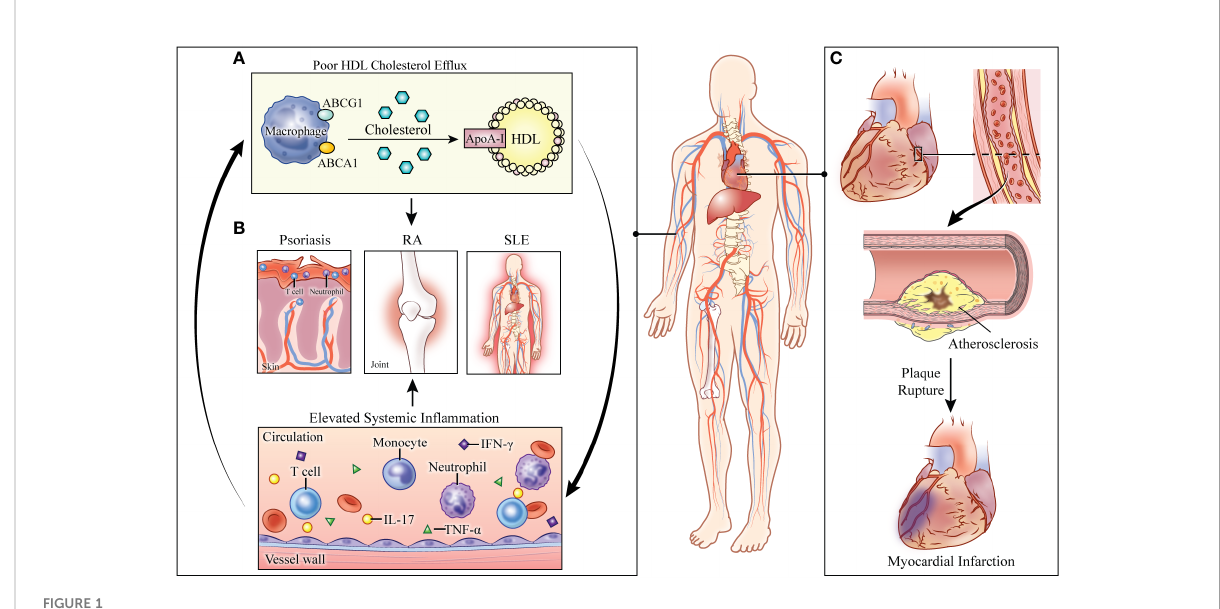
FIGURE 1 Consequences of abnormal cholesterol transport in systemically in fl amed pathologies. (A) Defective cholesterol ef fl ux capacity (CEC) perpetuates immune cell proliferation and activation. Elevated systemic in fl ammation further impairs cholesterol transport. (B) In the systemically in fl amed diseases of psoriasis, rheumatoid arthritis (RA), and systemic lupus erythematosus (SLE), CEC is associated with disease severity. (C) The combined effects of systemic in fl ammation and defective cholesterol transport lead to increased risk of cardiovascular disease and myocardial infarction in these pathologies. HDL: high-density lipoprotein. ABCG1: ATP-binding cassette subfamily G member 1. ABCA1: ATP-binding cassette subfamily A member 1. ApoA-1: apolipoprotein A1. RA: rheumatoid arthritis. SLE: systemic lupus erythematosus. IL: interleukin. TNF- a : tumor necrosis factor-alpha. IFN- g :